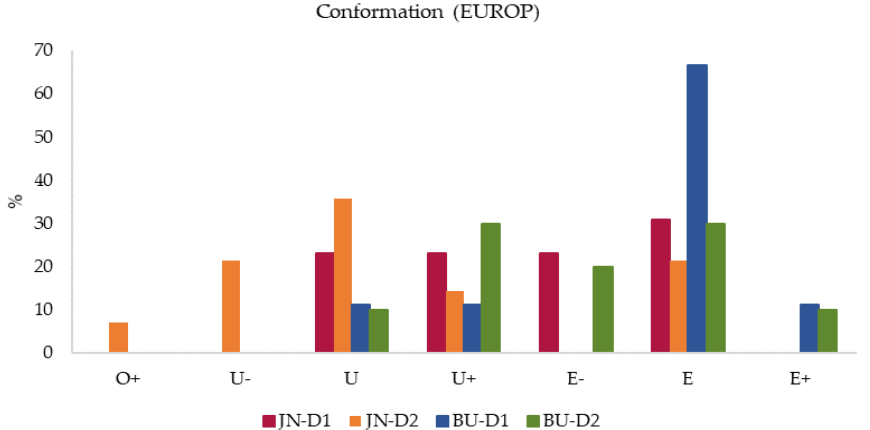
Figure 1. Percentage distribution of conformation of Jaca Navarra (JN) and Burguete (BU) foals fattened with two different finishing diets: D1 (Diet 1) = conventional concentrate, D2 (Diet 2) = Silage + organic concentrate.